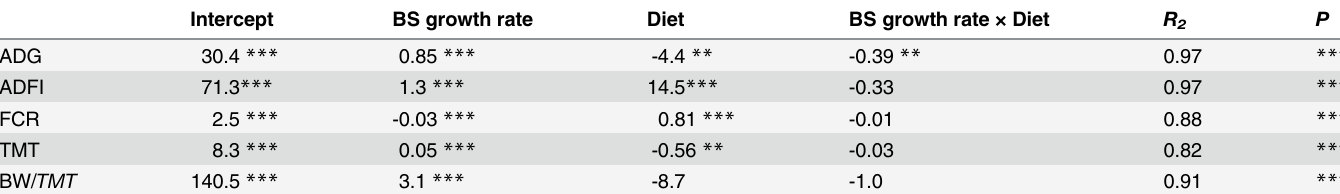
Table 2. The linear regression between both factors (BS growth rate and diet) and ADG, ADFI, FCR, TMT and BW/ TMT. Intercept BS growth rate Diet BS growth rate × Diet R 2